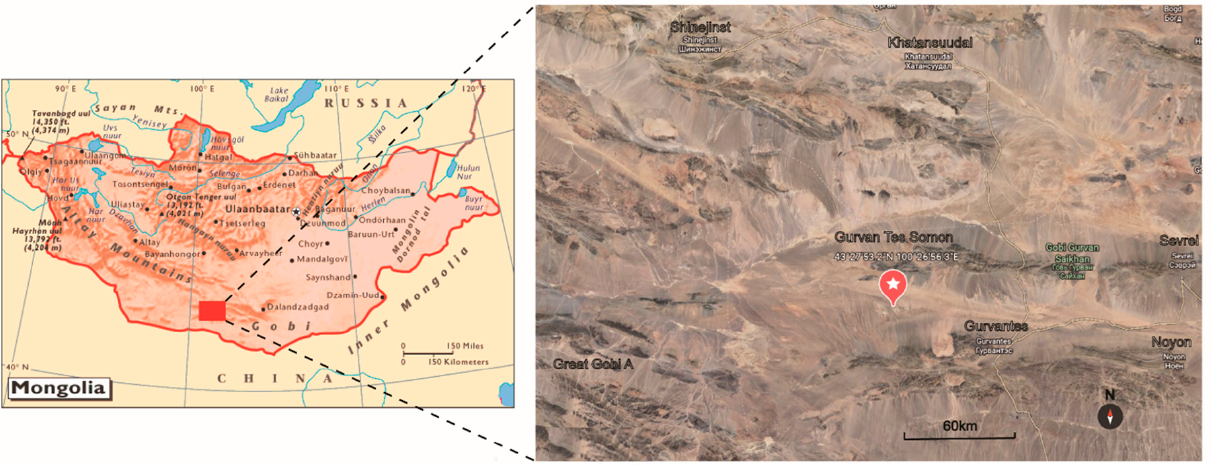
Figure 1. Sampling site. The map shows the sample collection site in Gurvan Tes Somon (Gurvan Tes County) in the Southern Gobi Aimak (Southern Gobi Province) in